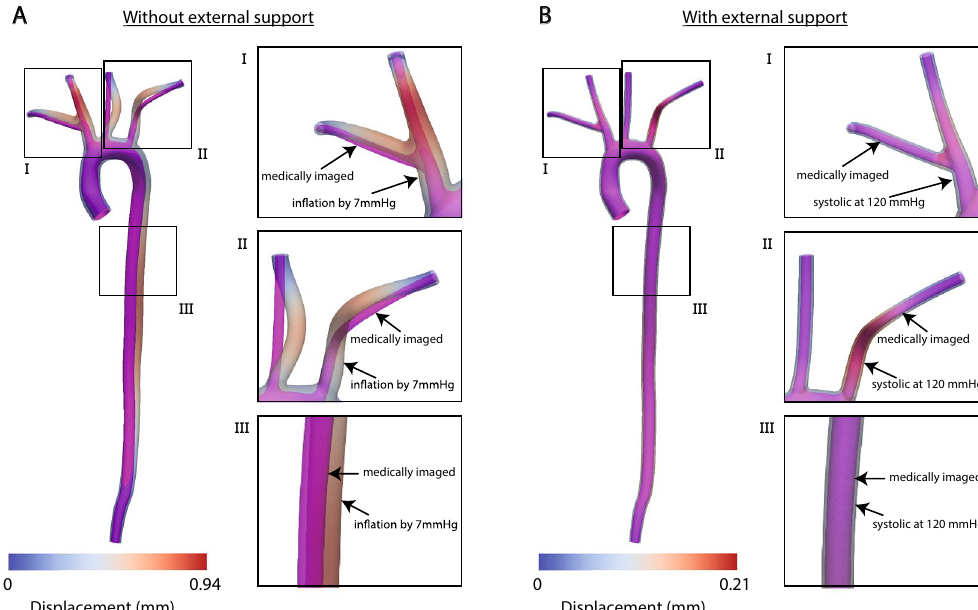
Figure 8. ( A ) Analysis without incorporation of external tissue support. The solution is characterized by unphysiological large deformations of the arterial wall leading to buckling in head branches and eventual failure 7 mmHg . ( B ) Analysis with the incorporation of external tissue support. The systolic of the simulation at P = 120 mmHg is characterized by a physiological range of arterial wall configuration at P =